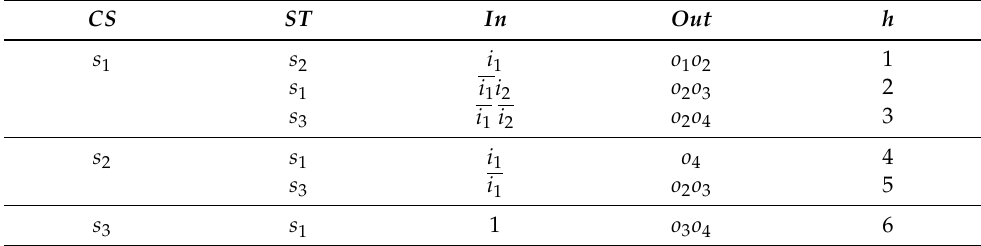
Table 2. State transition table of Mealy FSM